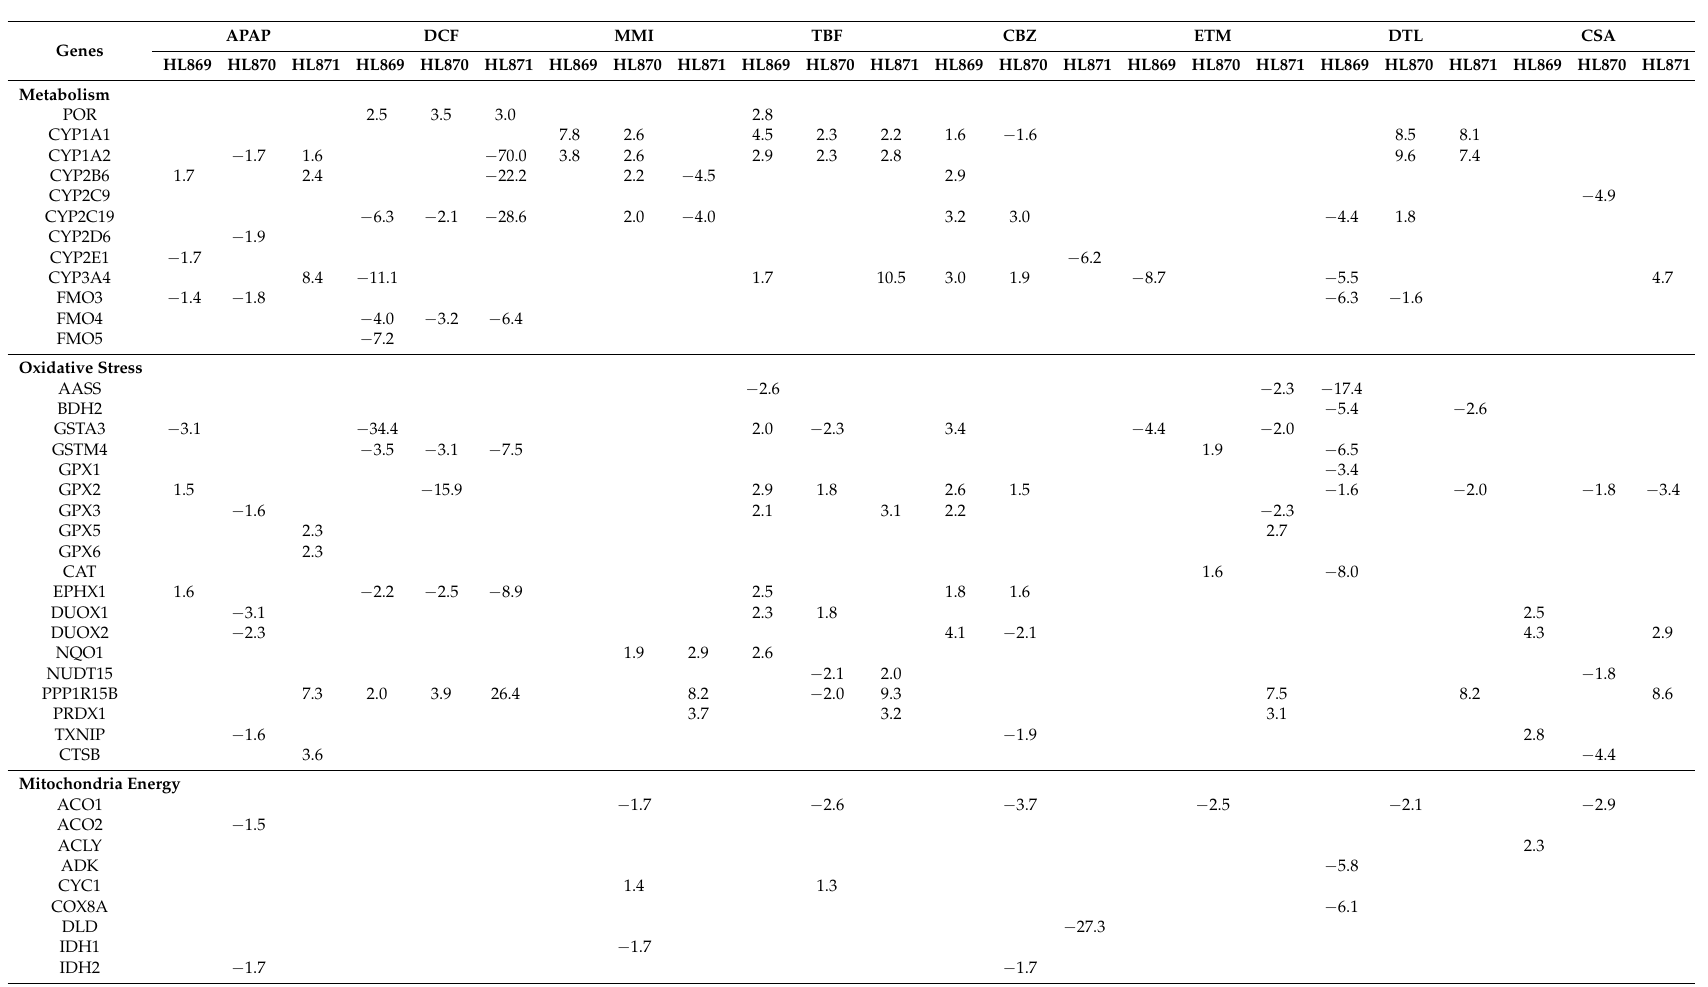
Table 4. Significant gene expression changes in human liver slices exposed daily for 48 h to APAP (1 mM), DCF (1 mM), MMI (500 µ M), TBF (100 µ M), CBZ (100 µ M), control and 6 treated